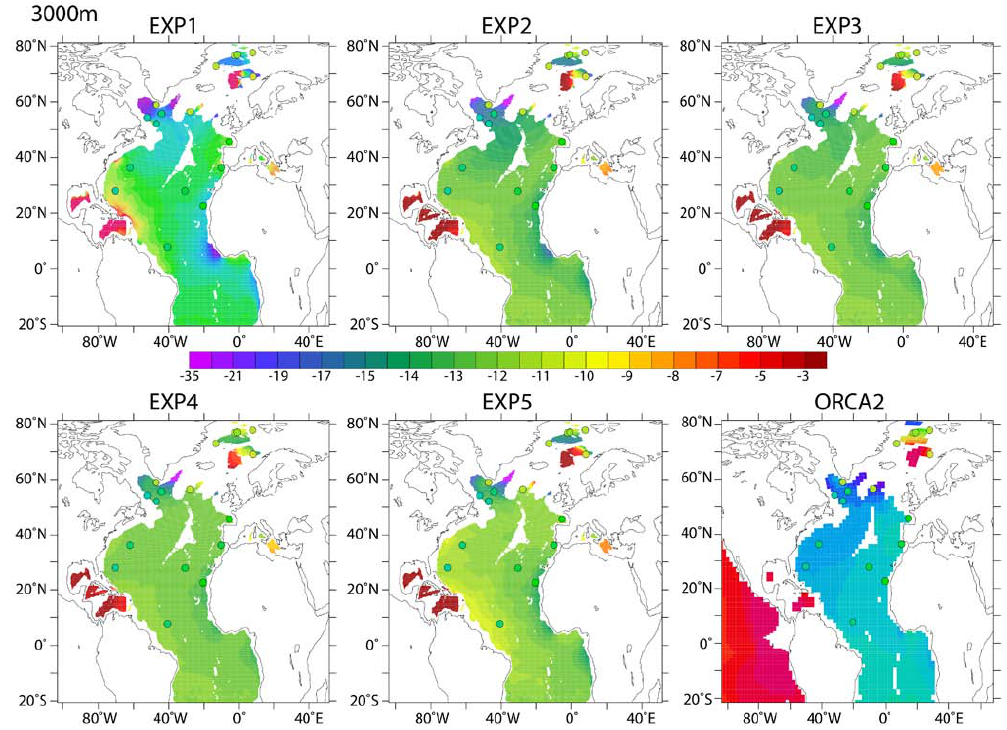
Fig. 4. Same as Fig. 2, but at 3000m depth. Data plotted (circles) are from 2500 to 3500m depth. Data are issued from Piepgras and Wasserburg (1980, 1983, 1987), Stordal and Wasserburg (1986), Spivack and Wasserburg (1988), Tachikawa et al. (1999), Lacan and Jeandel (2004a,b,c, 2005a,b), Dahlqvist and Andersoon (2005) and Rickli et al. (2009) and compiled by F. Lacan and K. Tachikawa (available here: http://www.legos.obs-mip.fr/fr/equipes/geomar/results/database